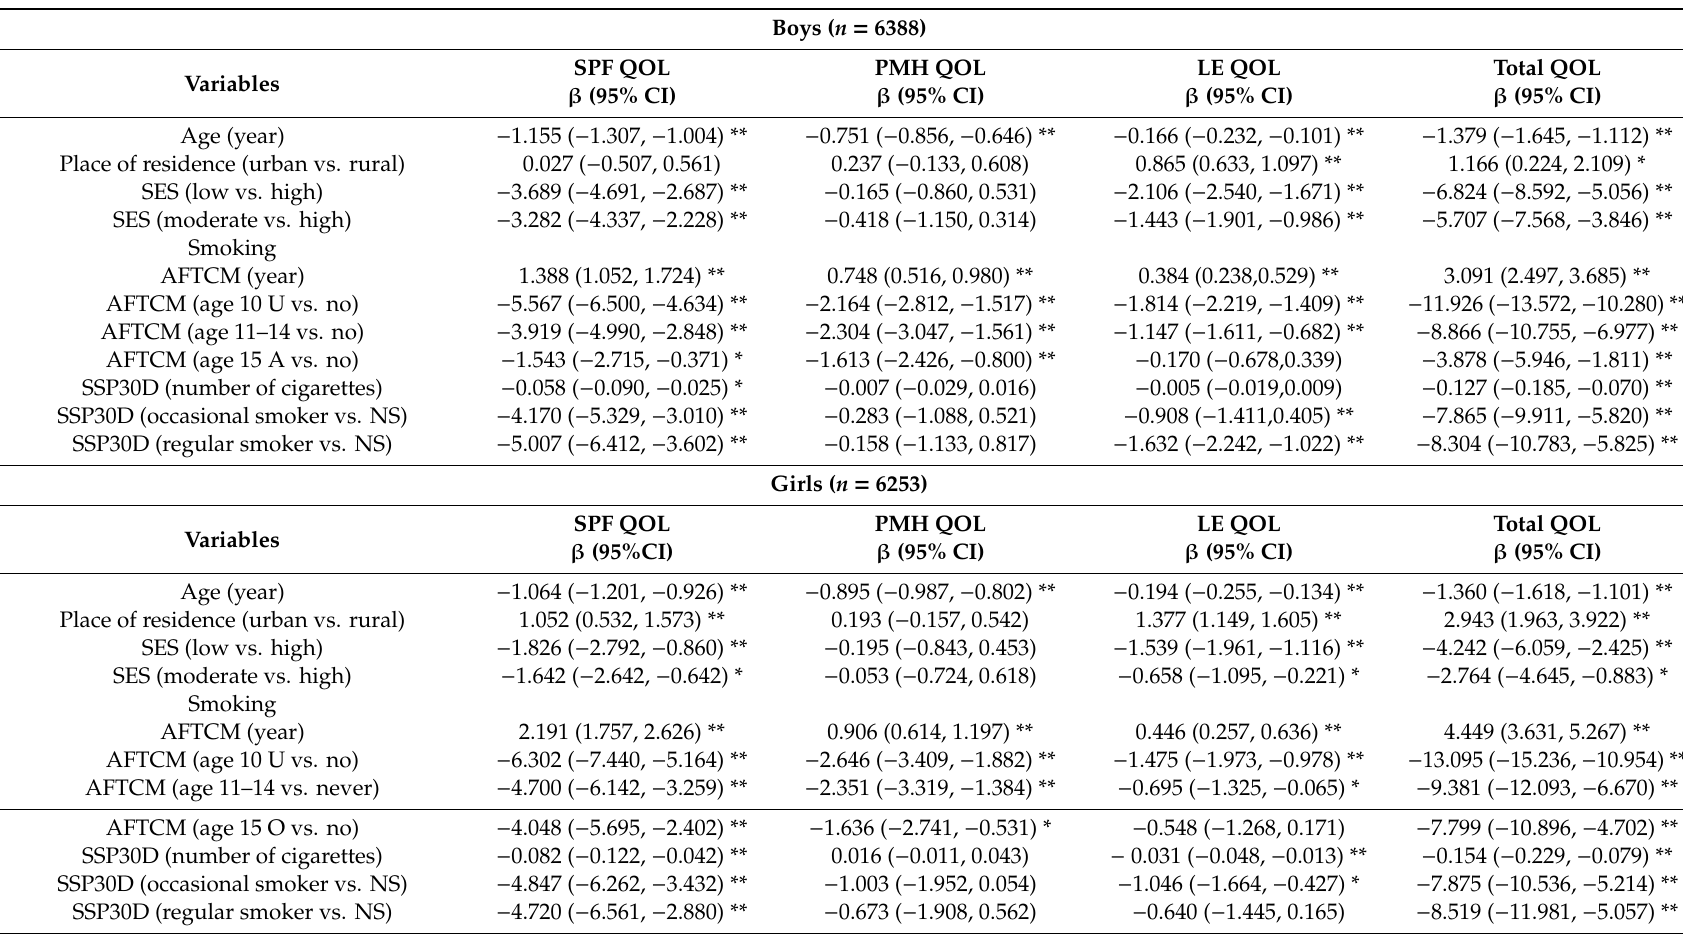
Table 3. Results from the multivariable general linear models evaluating the association of demographic factors and smoking with QOL in Boys and Girls. Boys ( n = 6388) SPF QOL PMH QOL LE QOL Total QOL Variables β (95% CI) β (95% CI) Place of residence (urban vs.